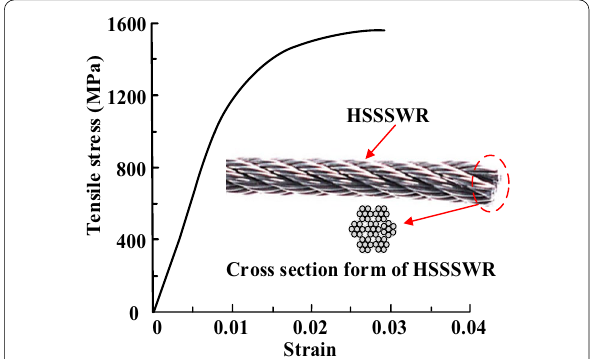
Fig. 3 Stress–strain curves of HSSSWRs.